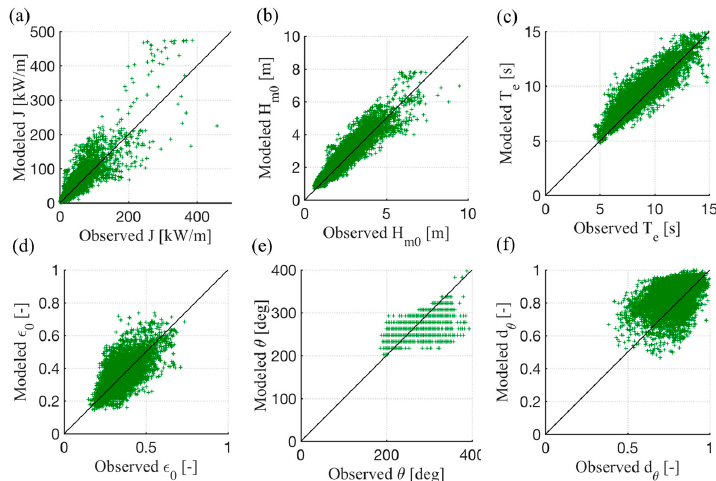
Figure 4. XY scatter plots of six IEC wave resource parameters for UnSWAN, using the ST2 physics package versus observed data. The solid black line indicates the 1:1 line.